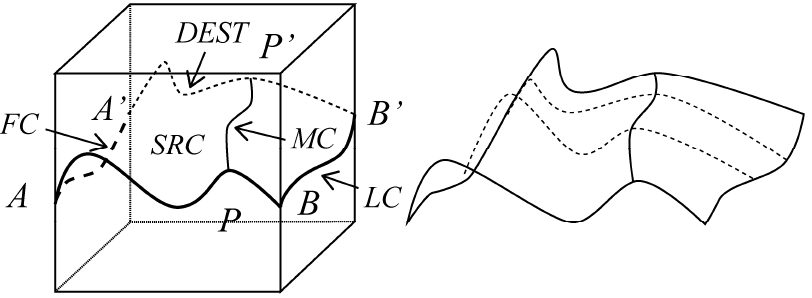
Figure 10. Schematic diagram of the mathematical model of the morphing technique.